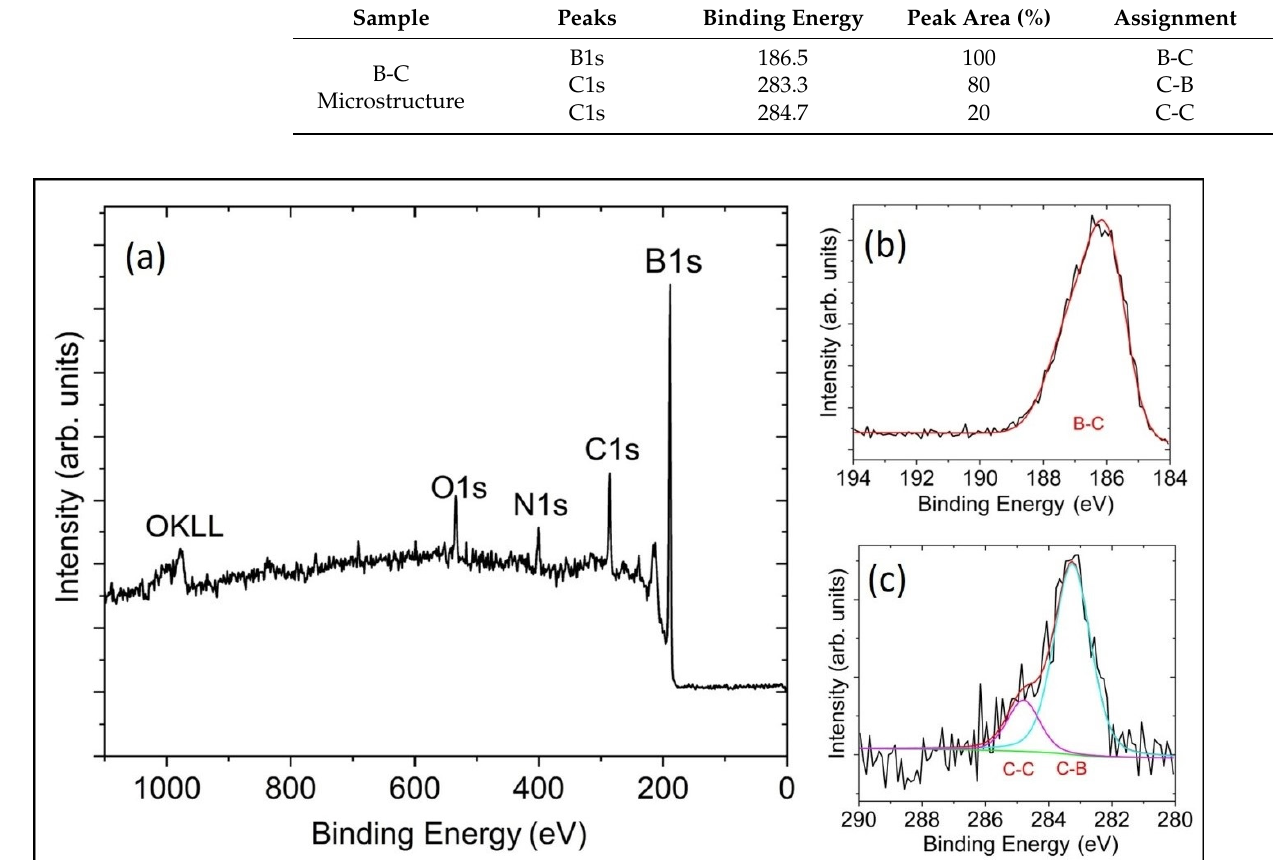
Table 1. XPS compositional analysis and fitted parameters of B1s and C1s. [19,20].